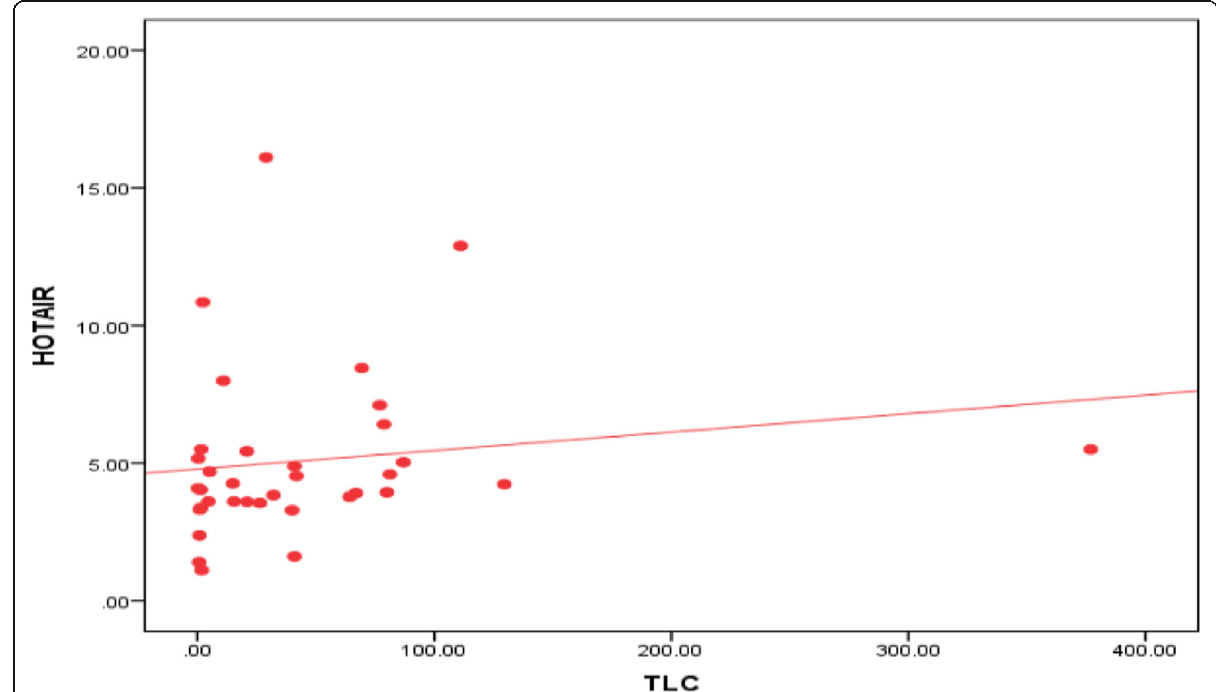
Fig. 3 Significant correlation between HOTAIR expression and TLC in AML